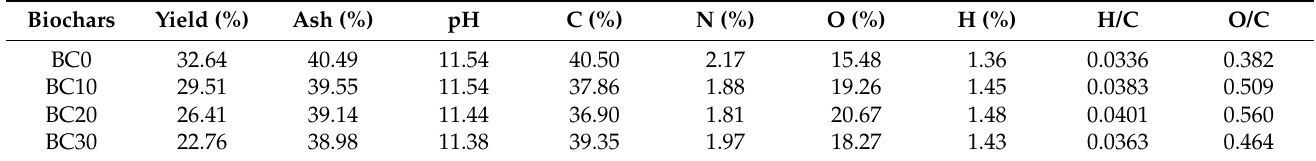
Table 1. Yield, ash contents, pH, elemental analysis, and atomic ratio of biochars derived from HS-PP blends.